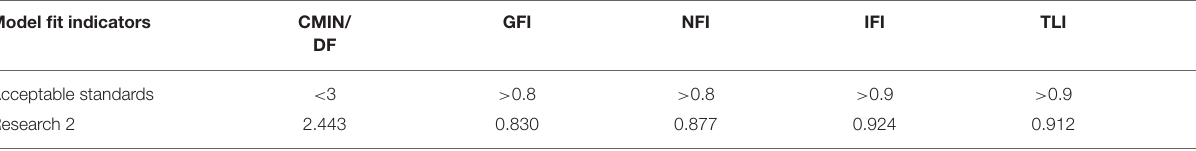
TABLE 4 | Model fit indicators and reference value.